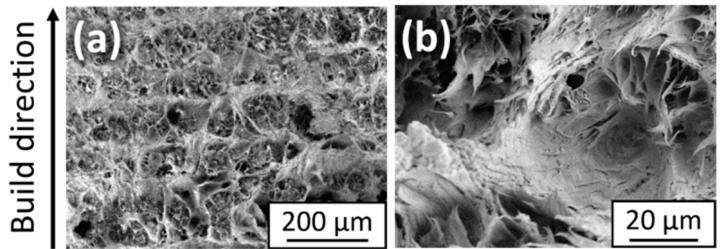
Figure 8. ( a ) Scanning electron microscopy images of the ductile area of fractured surfaces of the PA12 specimens. A more detailed view of the spherical fibrillated structures responsible for the ductility can be seen in ( b